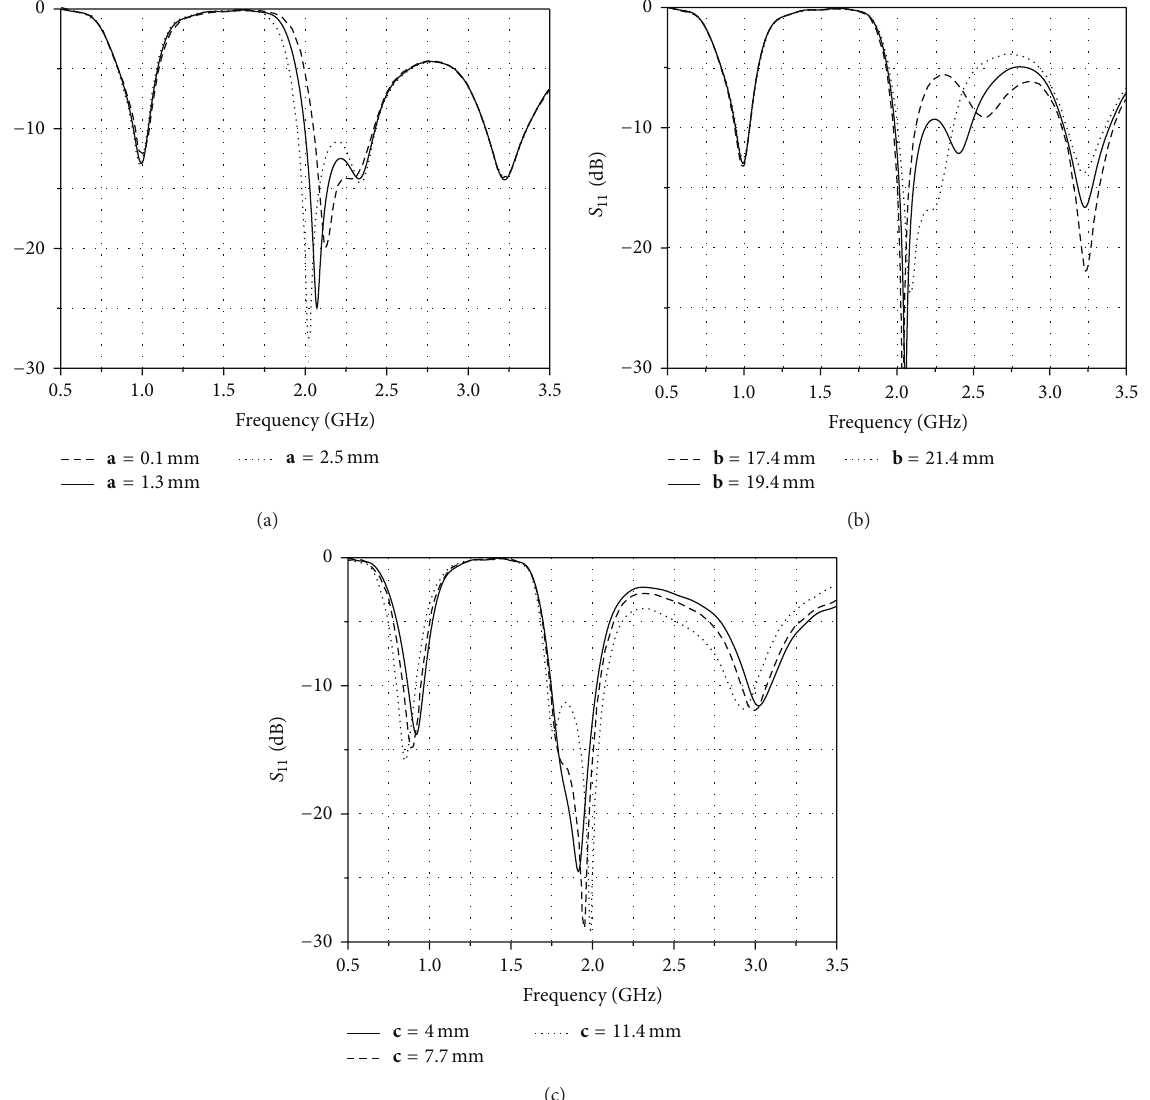
Figure 5: Simulated 𝑆 11 by varying the length of a , b , and c, as shown in Figure 1(c); (a) varying the length of a , b = 19.4 mm, and c = 4 mm, (b) a = 2.5 mm, varying the length of b , and c = 4mm, and (c) a = 2.5 mm, b = 19.4 mm, and varying the length of c .